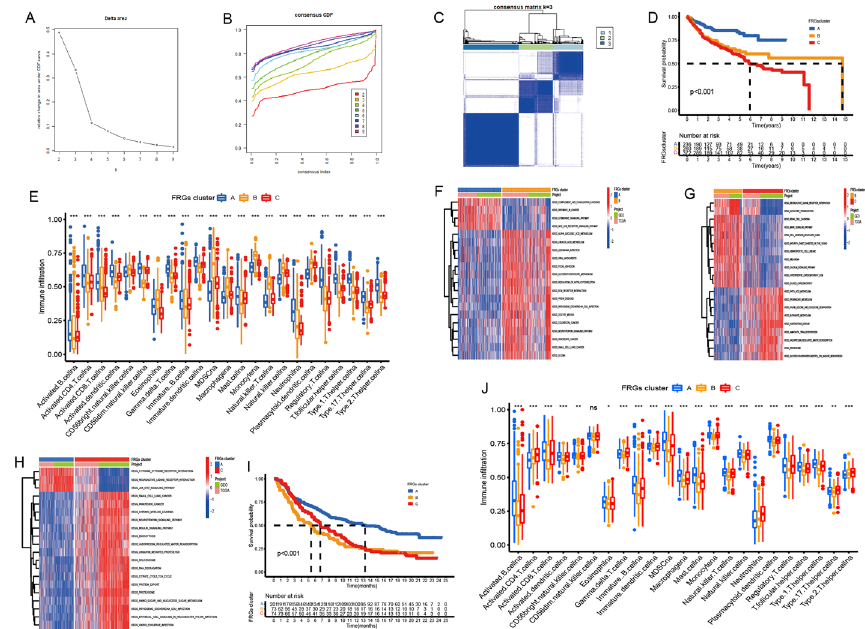
Fig. 5 Patterns of ferroptosis regulation modification and biological characteristics of each pattern. A – C Unsupervised clustering of 55 ferroptosis regulators in a meta cohort (TCGA D Survival analyses for the three ferroptosis regulation patterns based on 868 patients with BCa. E The abundance of TME infiltrating cells in three ferroptosis regulation patterns in meta cohort. F – H GSVA enrichment analysis. I Survival analyses in IMvigor210 cohort. J The abundance of TME infiltrating cells in three ferroptosis regulation patterns in IMvigor210